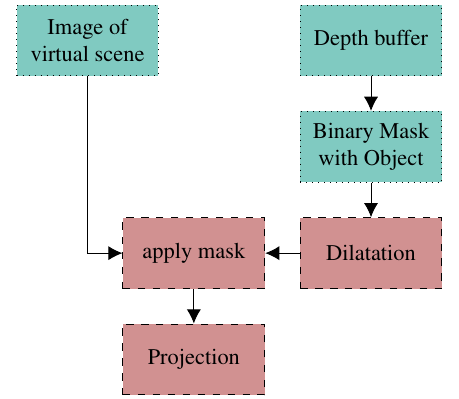
Figure 7. Process of applying a depth buffer-based mask on the projected image to remove unwanted